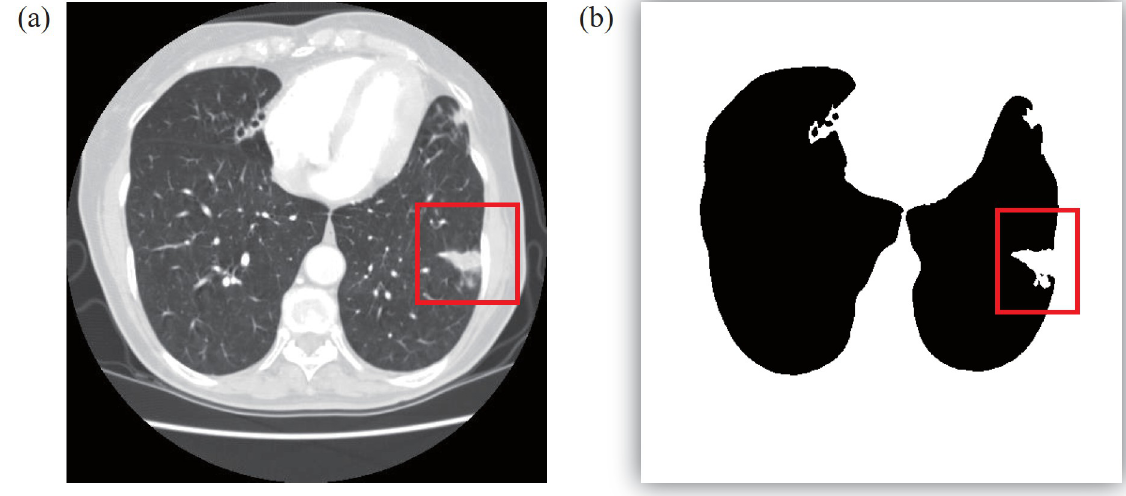
Fig 2. An example of the missed nodal area. (a) An original CT and (b) extracted lung region using a threshold method.